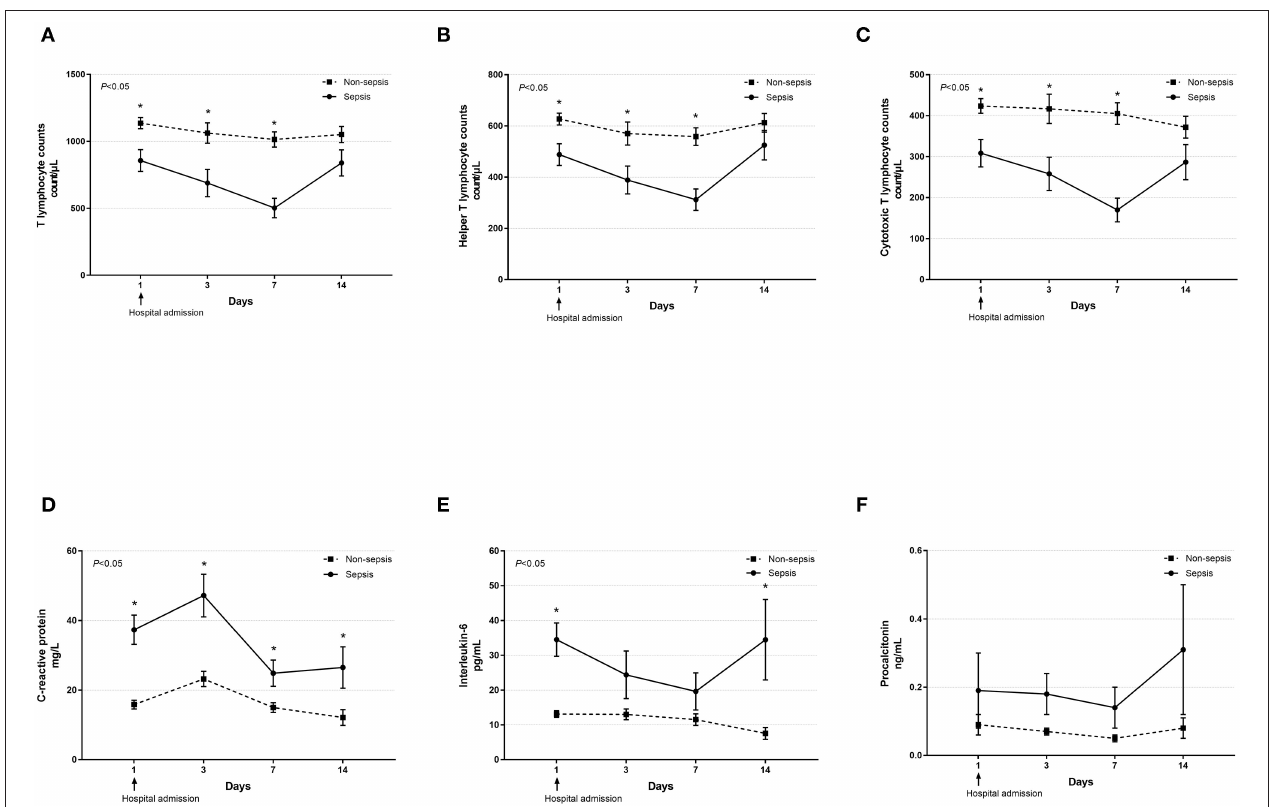
FIGURE 2 | Dynamic profiles of cell counts of various T lymphocyte subsets and levels of inflammatory biomarkers in septic and non-septic COVID-19 patients. The absolute counts of T lymphocytes (A) , helper T lymphocytes (B) , and cytotoxic T lymphocytes (C) as well as serum levels of C-reactive protein (D) , interleukin-6 (E) , and procalcitonin (F) in septic and non-septic COVID-19 patients were monitored and compared on days 1, 3, 7, and 14 after hospital admission. Data were presented as mean ± SEM. * P < 0.05, septic patients vs. non-septic patients. Results were tested for significance by using a general linear model with corrections for repeated